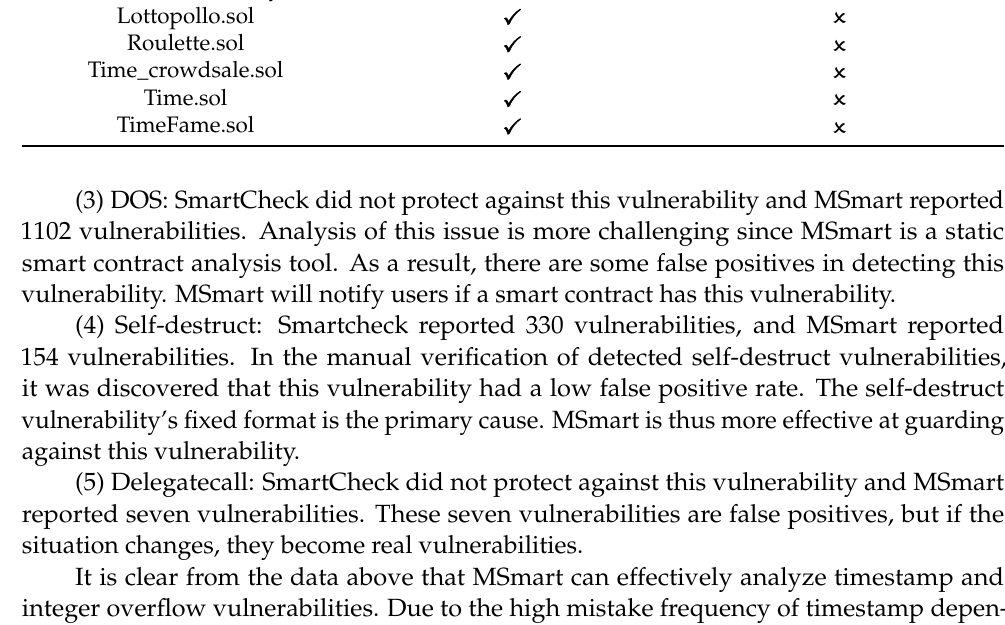
Figure 9. uint256 (cnt) * _value code analysis tree. Table 1. Differences between MSmart and Smartcheck. Table 3. Timestamp issue statistics results.